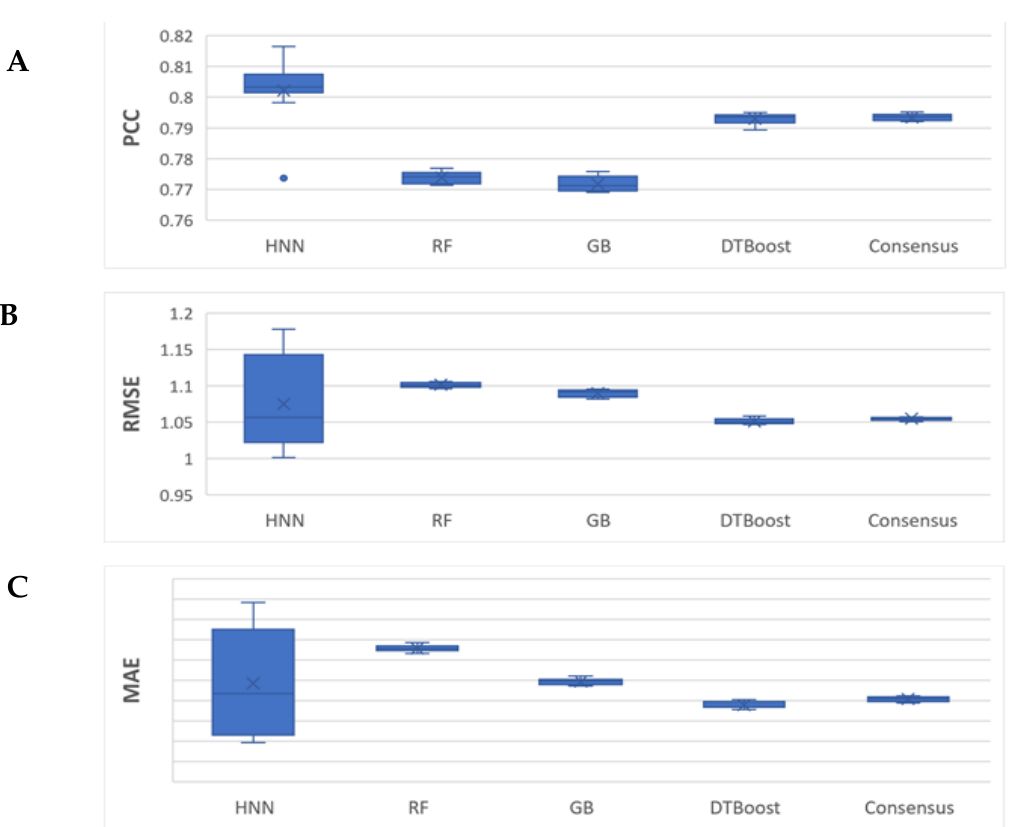
Figure 4. The HNN-denovo performance comparison to other models for the combined K d binding data. ( A ) PCC, ( B ) RMSE, and ( C ) MAE of the binding affinity prediction by HNN, RF, GB, DT, and consensus methods.